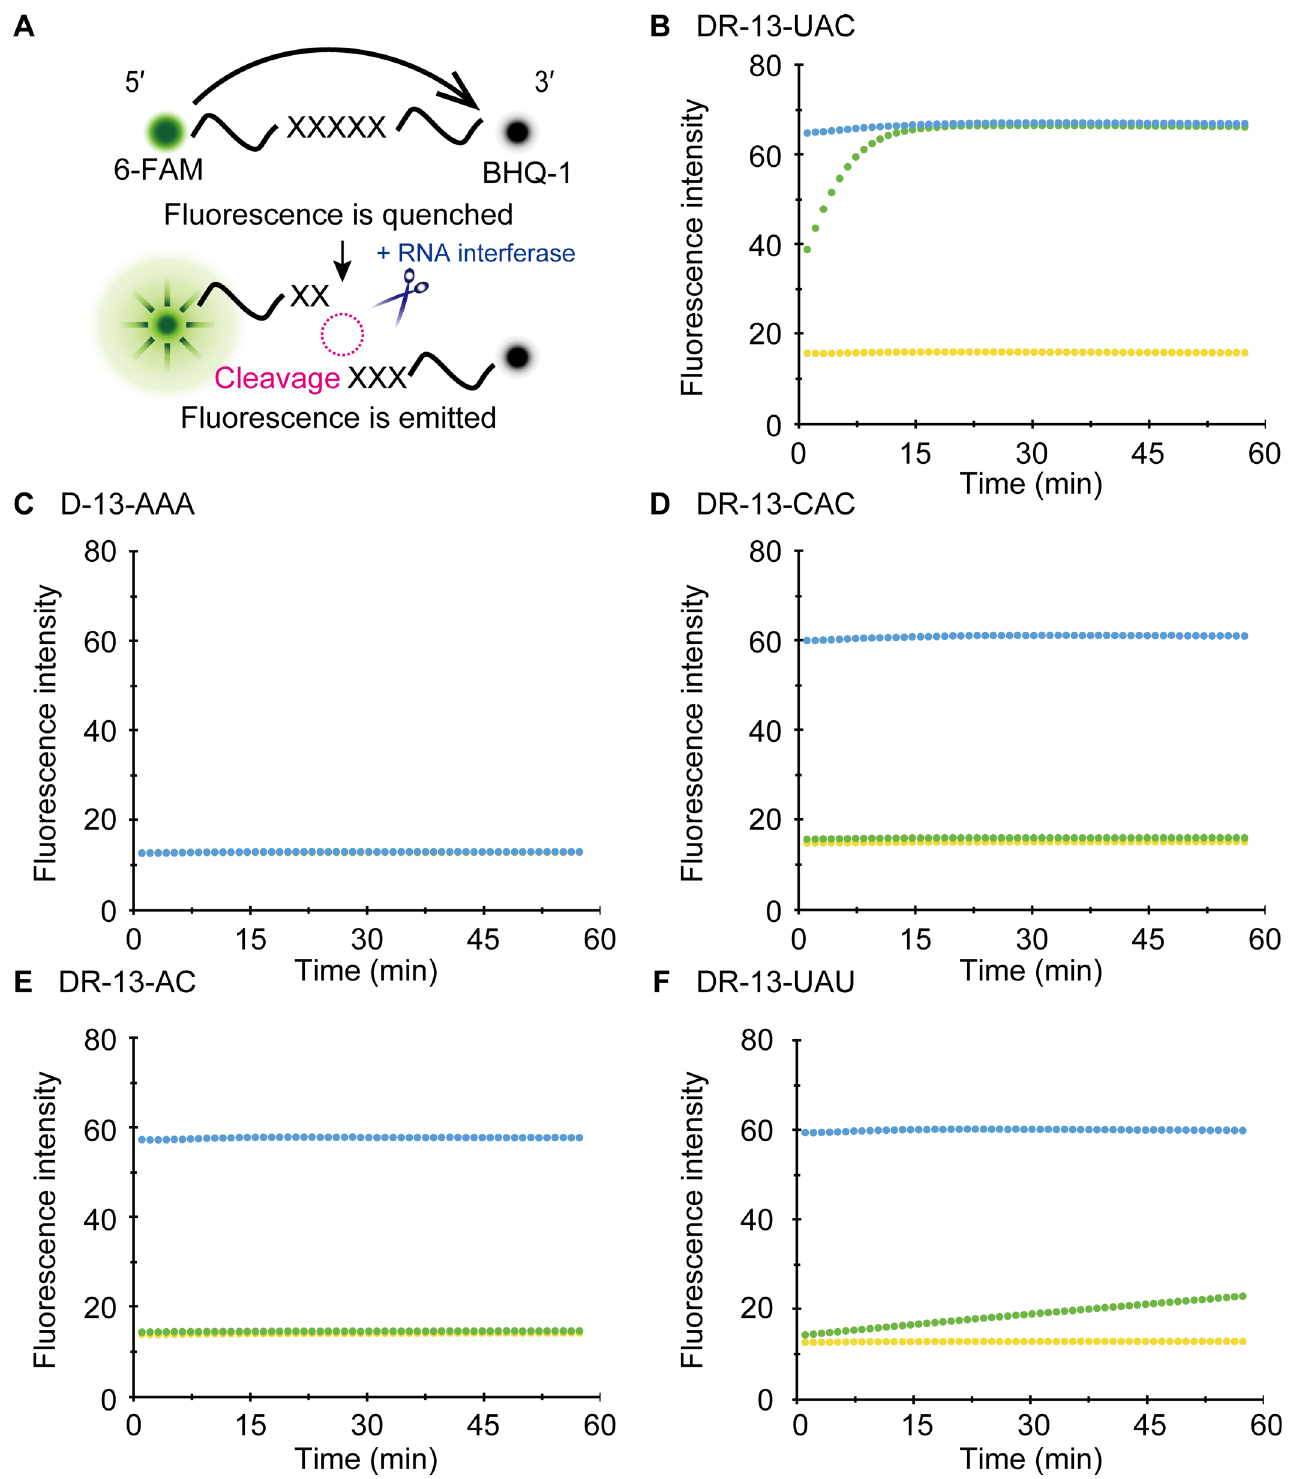
Fig 5. Fluorometric detection. (A) Principle of the fluorometric detection based on the fluorescence resonance energy transfer [34]. The fluorescent of 6-FAM is typically quenched by BHQ-1, but it emits a bright signal when the oligonucleotide is cleaved. (B-F) Investigation on the MazFpp cleavage site. One hundred nanograms of RNase A (blue) or MazFpp (green) was incubated with each oligonucleotide. The yellow plot represents a control reaction in which no enzyme was added.